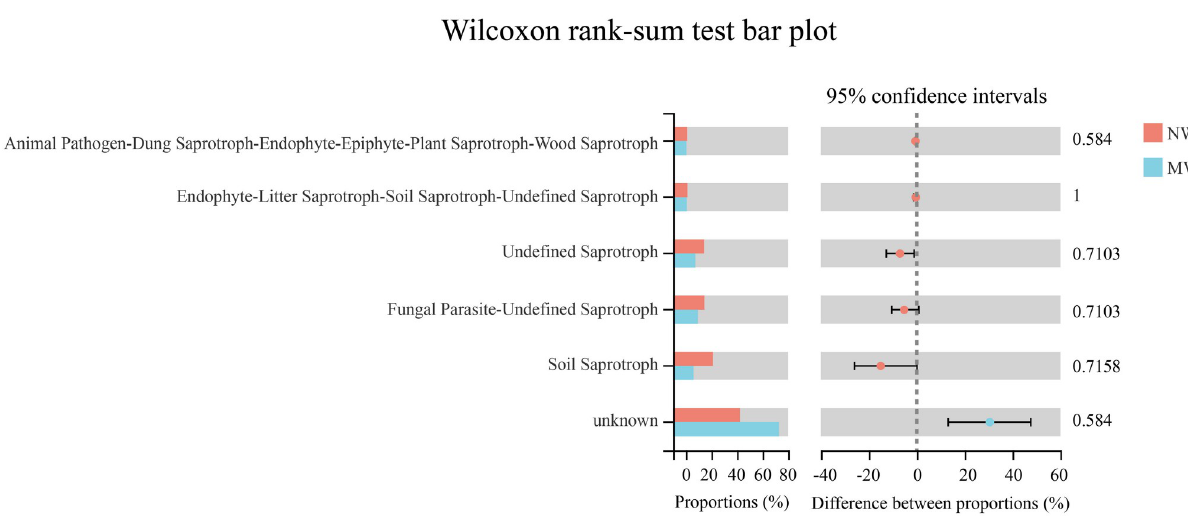
Fig 7. Functional predictions of the soil fungal communities between the NW and MW treatments. Note . NW: no weeding in the star anise plantation, and MW: mechanical weeding in the star anise plantation. The Wilcoxon rank-sum test was performed ( P < 0.05).